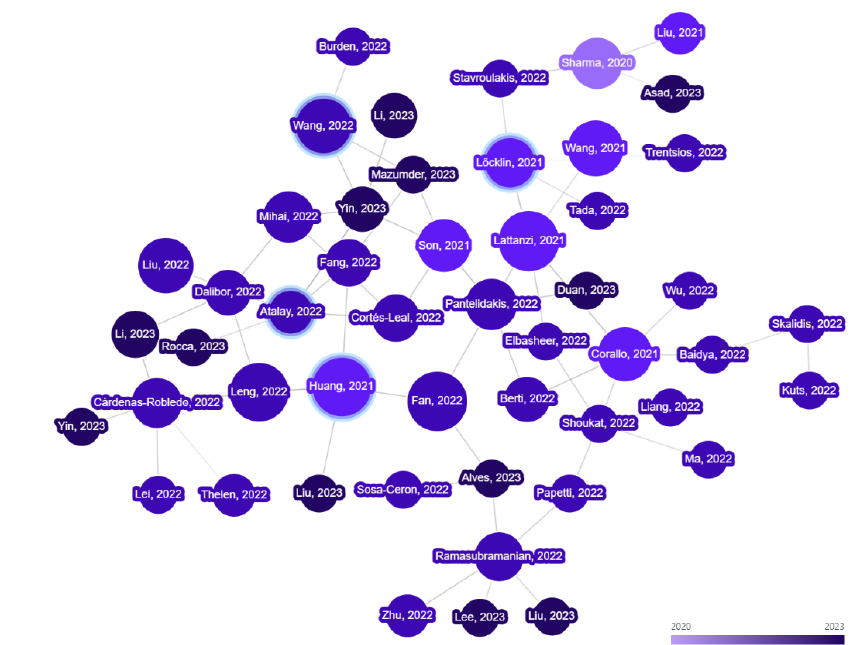
Figure 3. Citation Network Graph. Table 1. Most cited articles in this